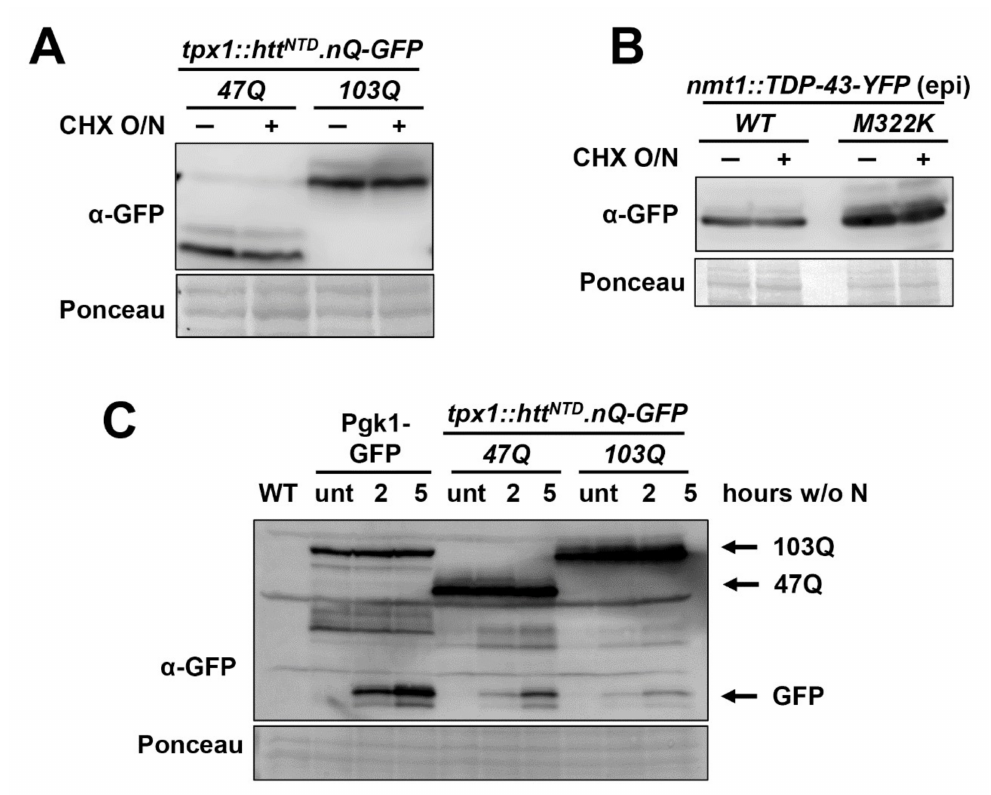
Figure 3. Htt NTD .nQ-GFP and TDP-43-YFP are not degraded by the UPS or autophagy. ( A ) The levels of Htt NTD .nQ-GFP were analysed by Western blot of TCA extracts from strains expressing tpx1 -driven-Htt NTD .nQ-GFP (AB1.47Q and AB1.103Q) that were either untreated ( − ) or treated (+) overnight with 0.1 mg/mL cycloheximide (CHX). Ponceau staining was used as loading control. ( B ) The levels of TDP-43-YFP were analysed by Western blot of TCA extracts from strains expressing TDP-43-YFP or TDP43.M233K-YFP from an nmt1 episomal plasmid [HM123 transformed with p660.3x ( WT ) and p660.M322K.3x ( M322K )] that were grown in MM and treated as in A. Ponceau staining was used as loading control. ( C ) Levels of Pgk1-GFP, Htt NTD .nQ-GFP and cleaved GFP were determined by Western blot from TCA extracts obtained from a wild-type (972) and strains expressing Pgk1-GFP (RB44) or tpx1 -driven Htt NTD .nQ-GFP (AB1.47Q and AB1.103Q) growing in the absence of a nitrogen source for the indicated time. Ponceau staining was used as loading